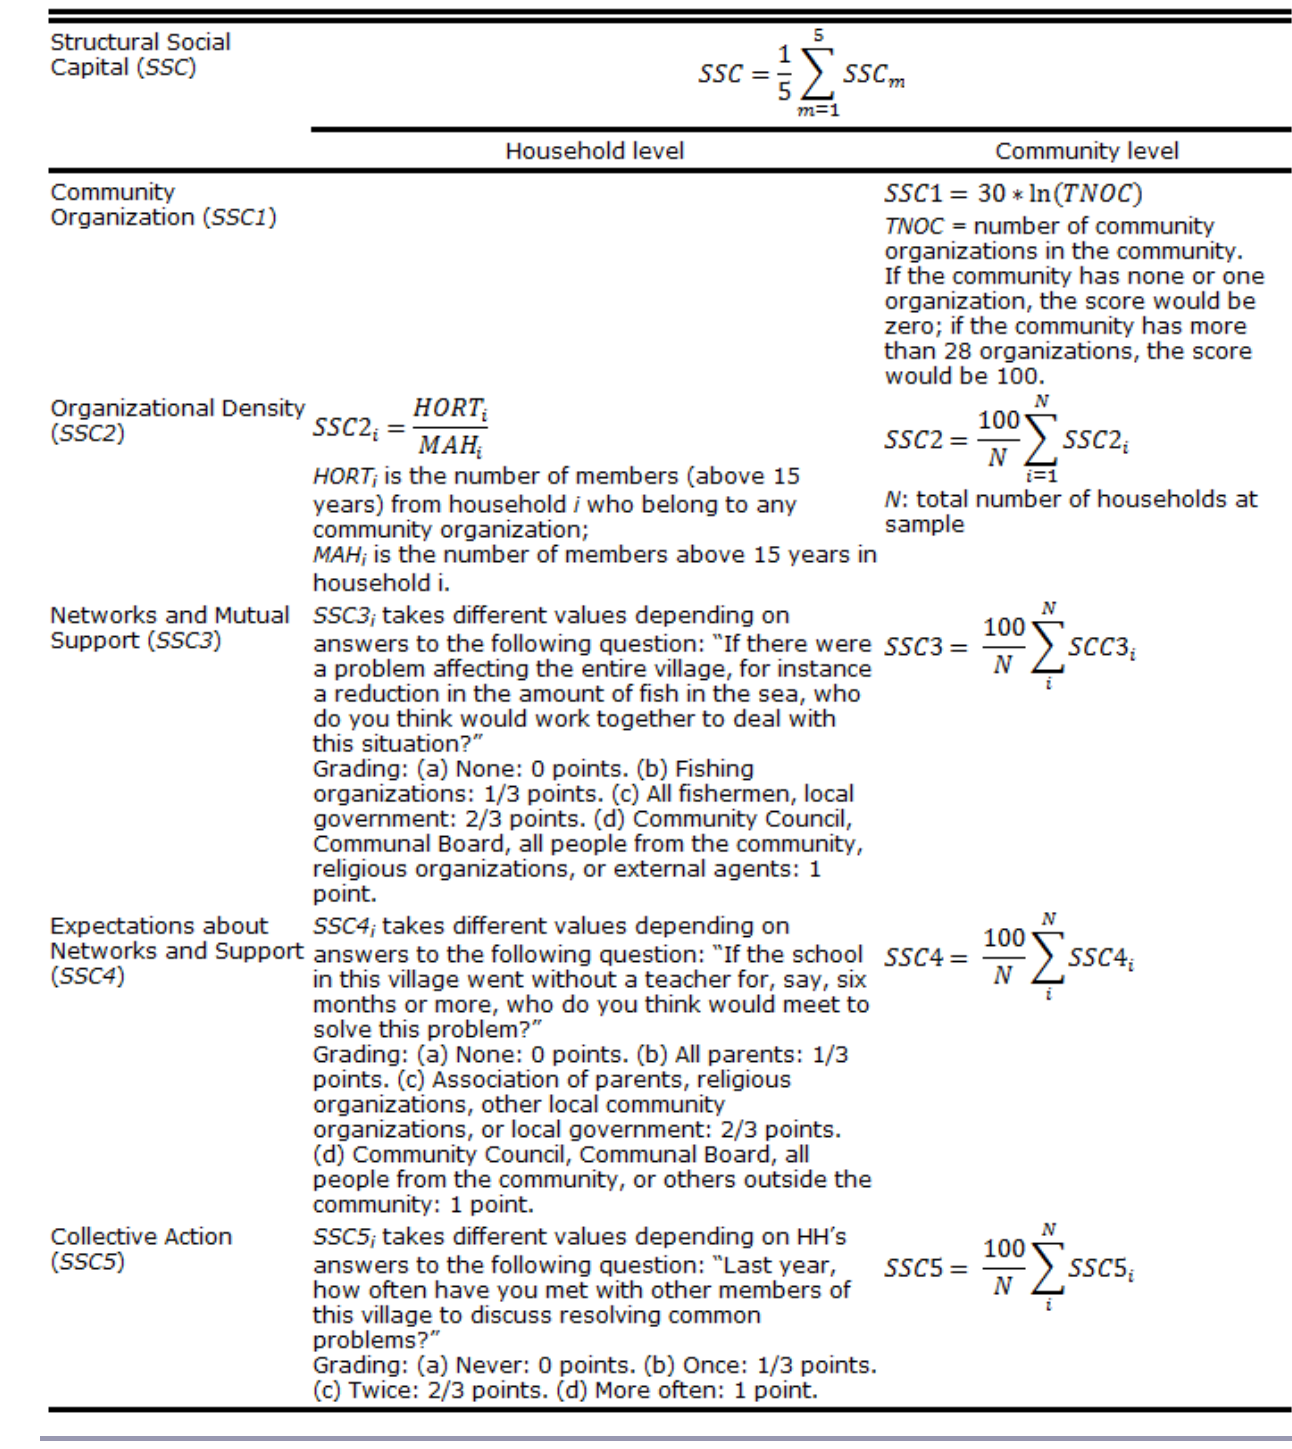
Table 4 . Calculation of structural social capital indicator and